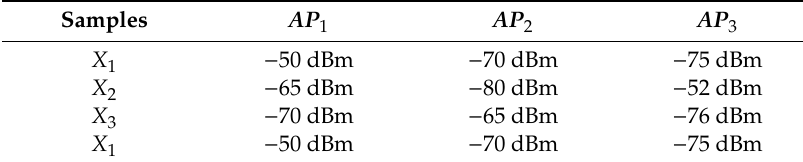
Table 1. An example dataset with raw RSS feature for 3 access points.